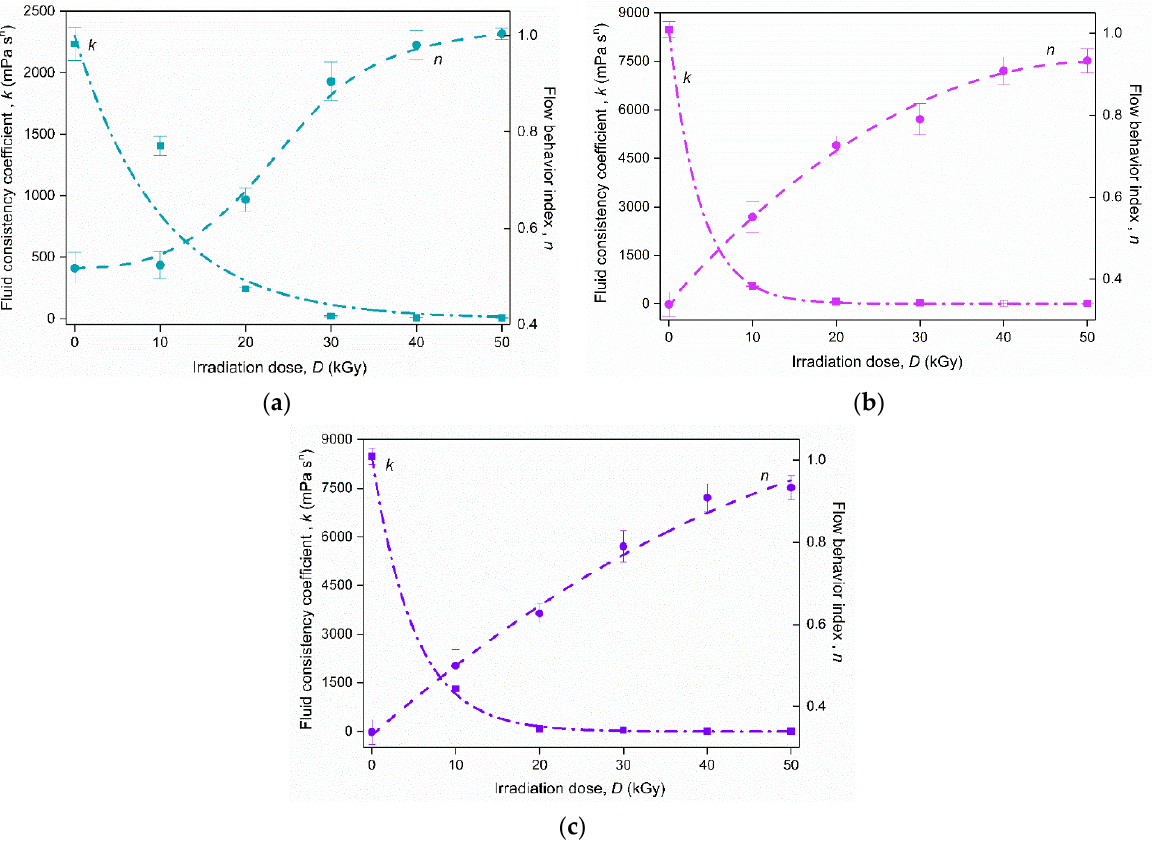
Figure 2. Rheological parameters of the Ostwald de Waele model for samples exposed to ( a ) EBI, ( b ) CED/EBI, and ( c ) EBI/CED.